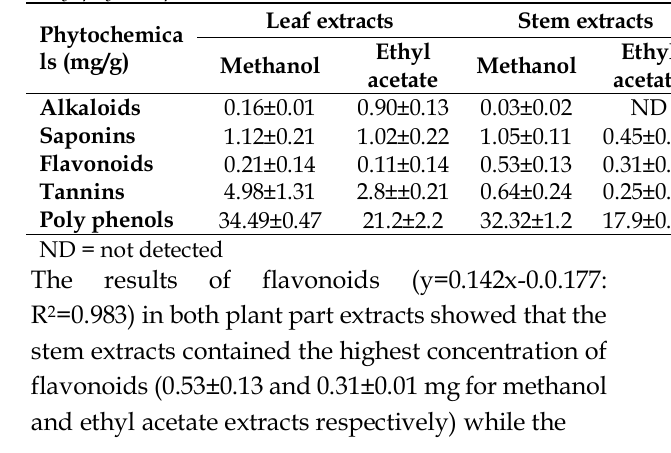
Table 2 : Quantification of the Phytochemicals in the extracts of